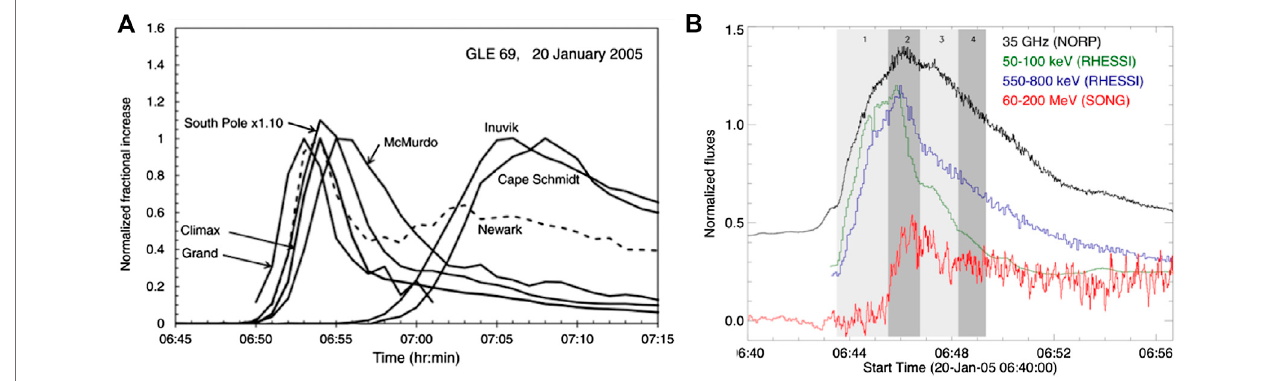
FIGURE 3| Time history ofthe relativistic SEP event on 2005 Jan20. (A) Neutron monitor count ratesshowing the two parts of the event (McCracken et al., 2012, ©AAS). (B) Microwave (35 GHz), hard X-ray and gamma-ray emission during the impulsive phase of the fl are (Masson et al., 2009). The shaded intervals distinguish different acceleration episodes. ©Springer Nature. Figures reproduced with